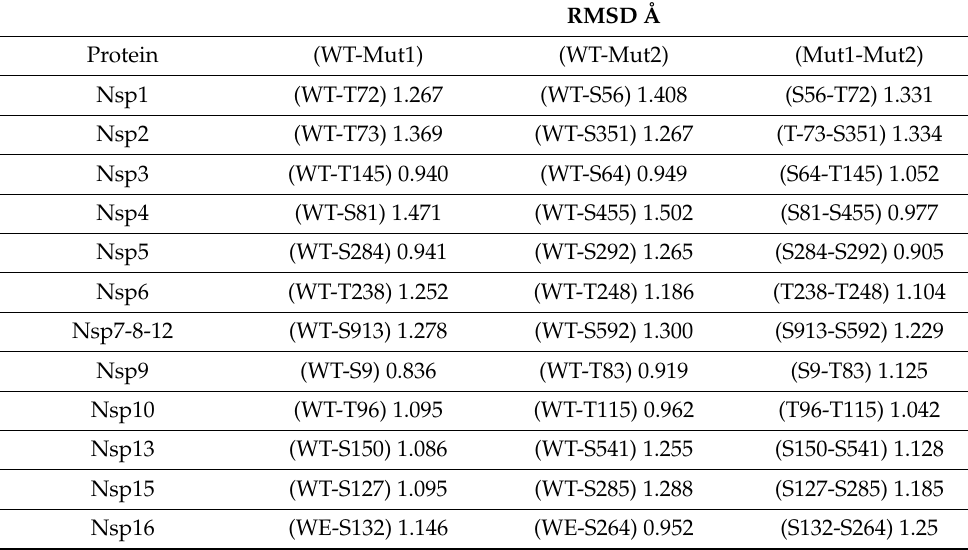
Table 3. RMSD differences between wild type and phosphorylated